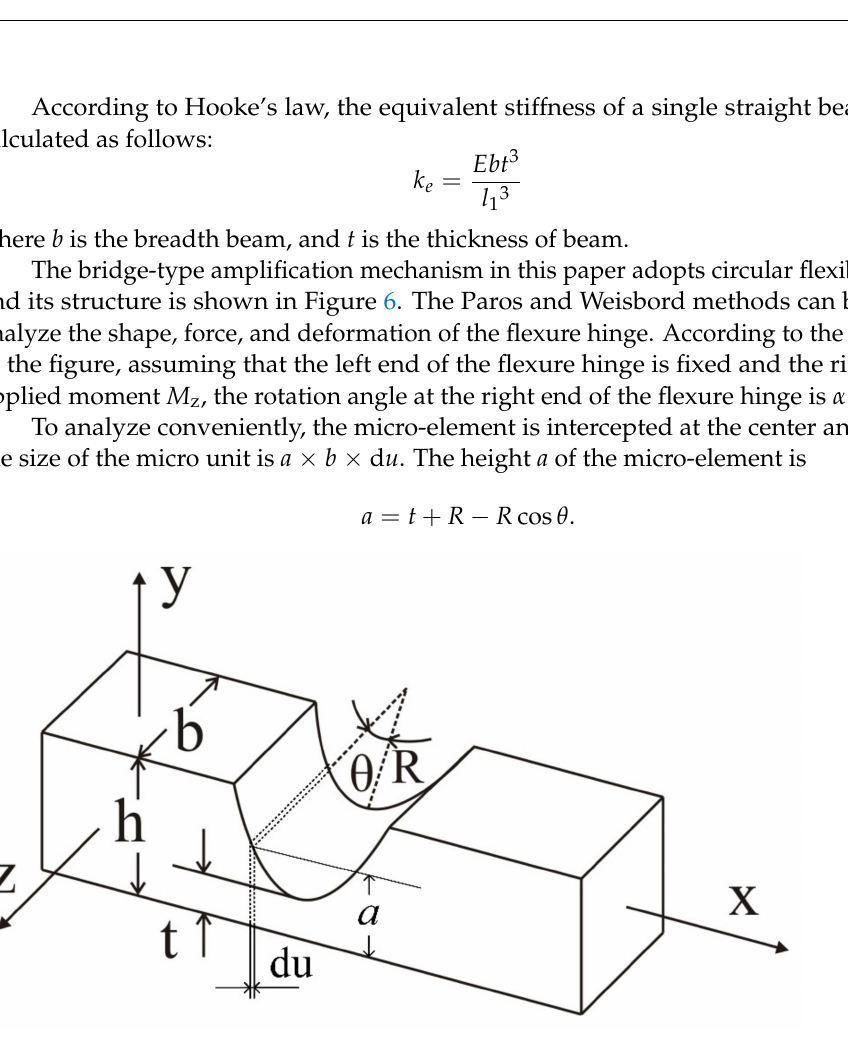
Figure 6. The structure of the circular flexible